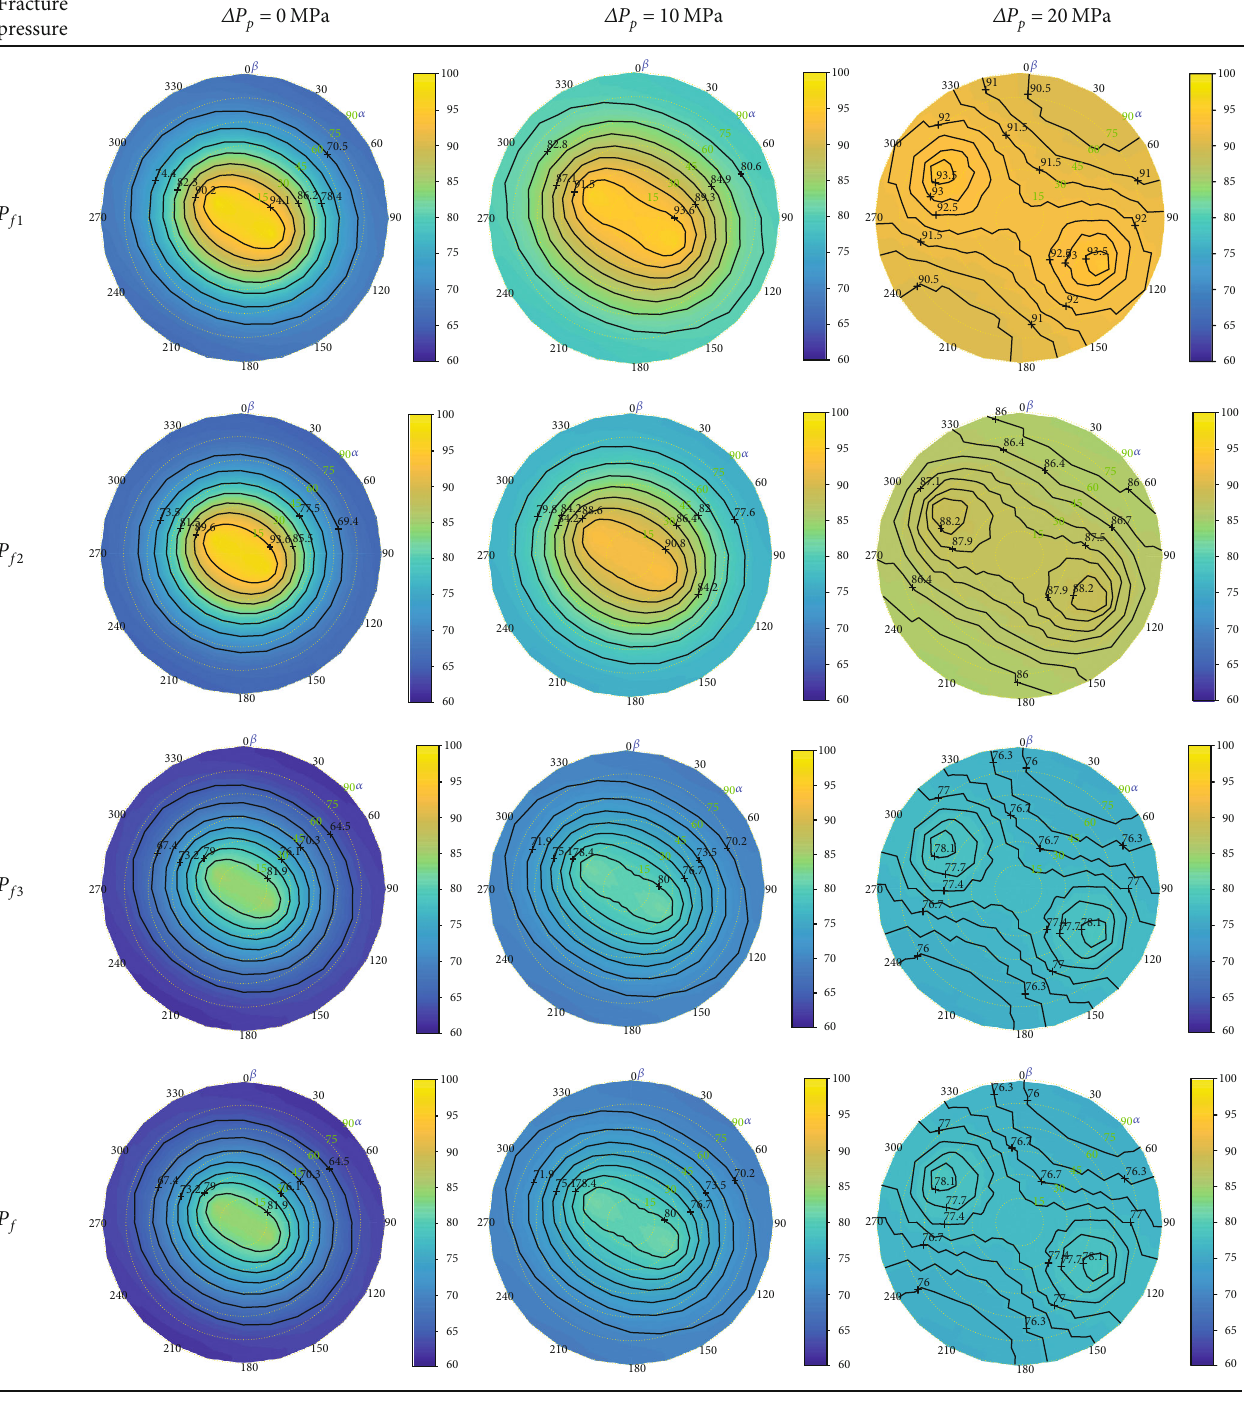
Table 3: The change of fracture pressure with reservoir depletion of directional wellbore drilled in reverse fault stress regime. Fracture